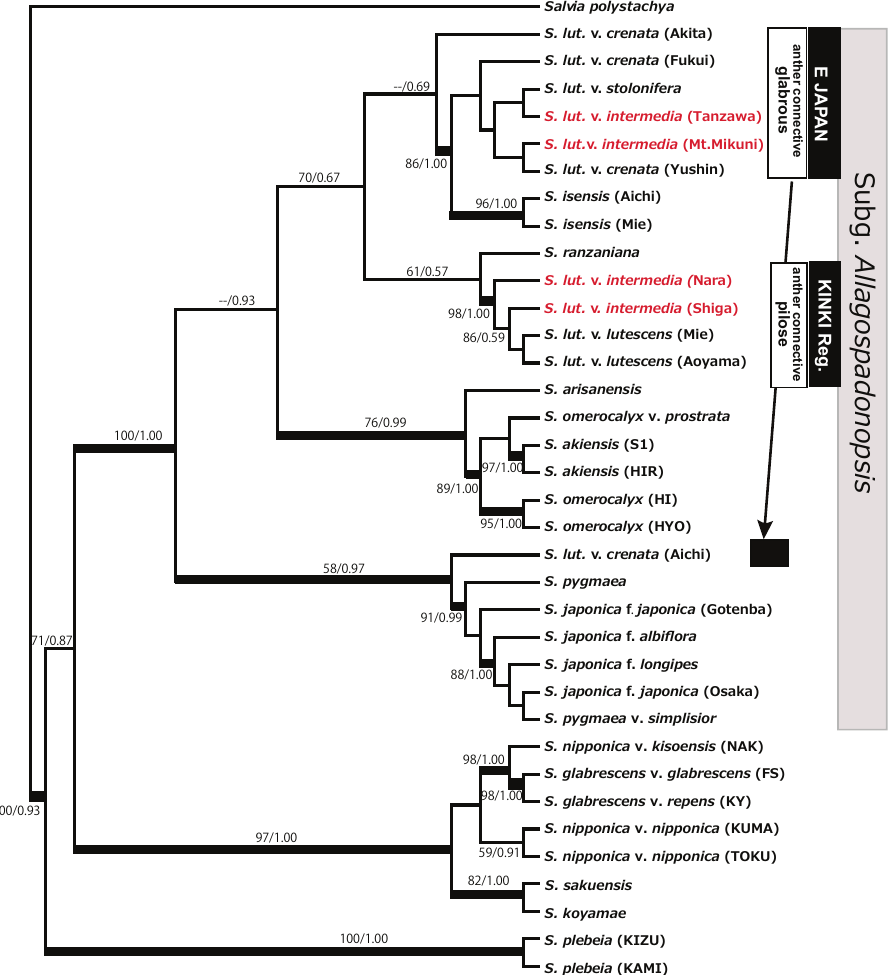
Figure 5. The Bayesian maximum clade credibility tree derived from nuclear ribosomal DNA (con- catenate dataset of ETS and ITS). ML-bootstrap/Bayesian-PP numbers are shown above or below the cor- responding branch. Thick lines denote a clade that was strongly supported with ML-bootstrap and/or Bayesian-PP values greater than 95 %. ML: maximum likelihood; PP: posterior